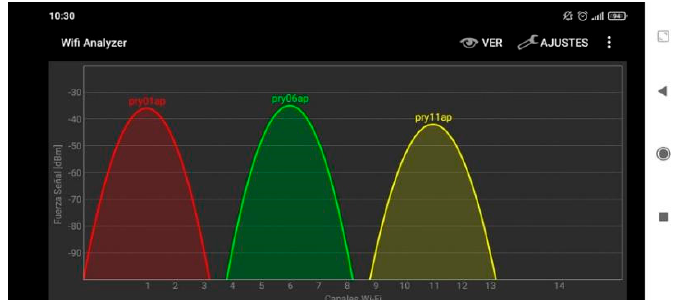
Figure 11. WiFi interference generators. Each colour shows an individual WiFi Network and its relation to signal strength and WiFi channel occupation.